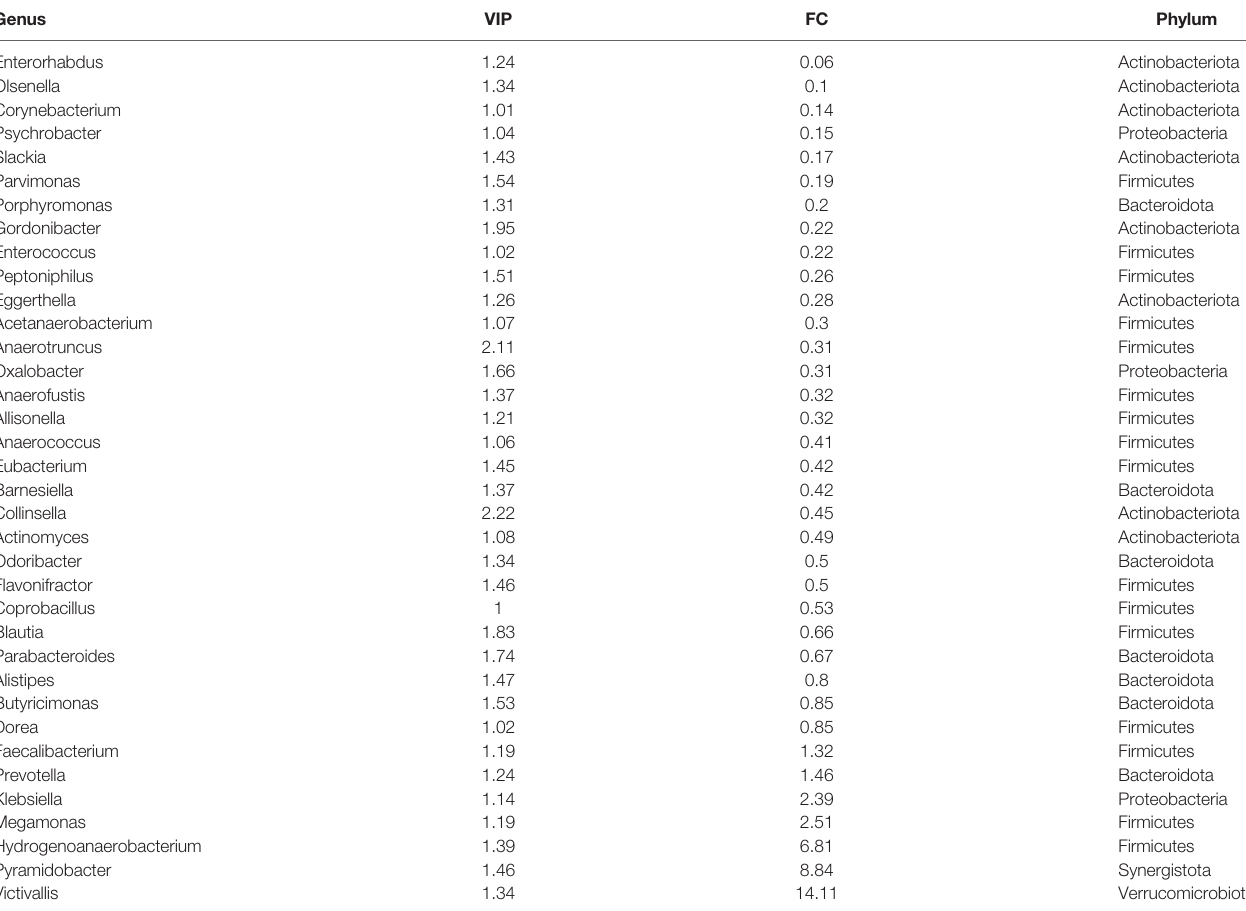
TABLE 2 | Differential genera responsible for discriminating moderate MDD patients from